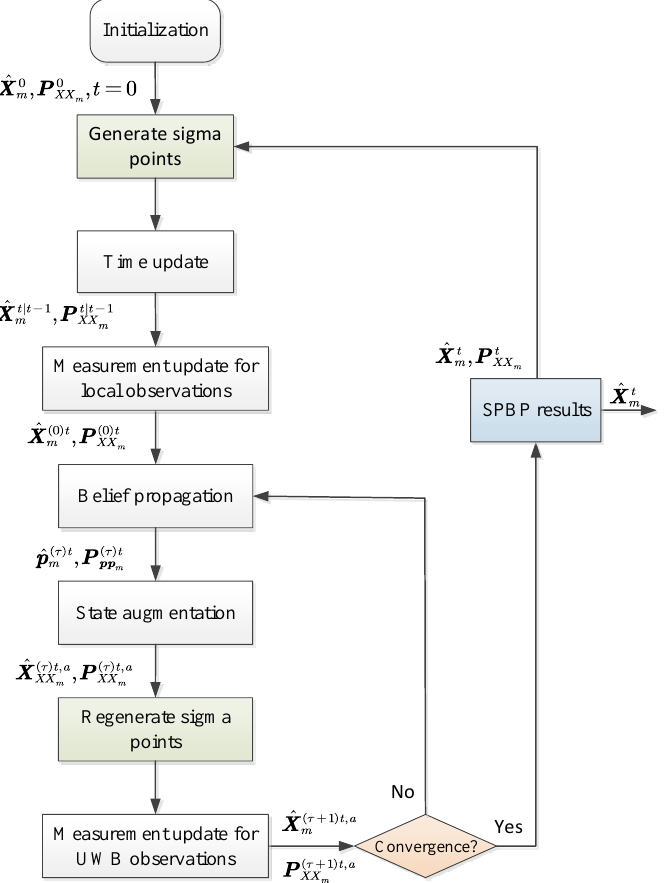
Figure 3. Procedure for the proposed SPBP algorithm.